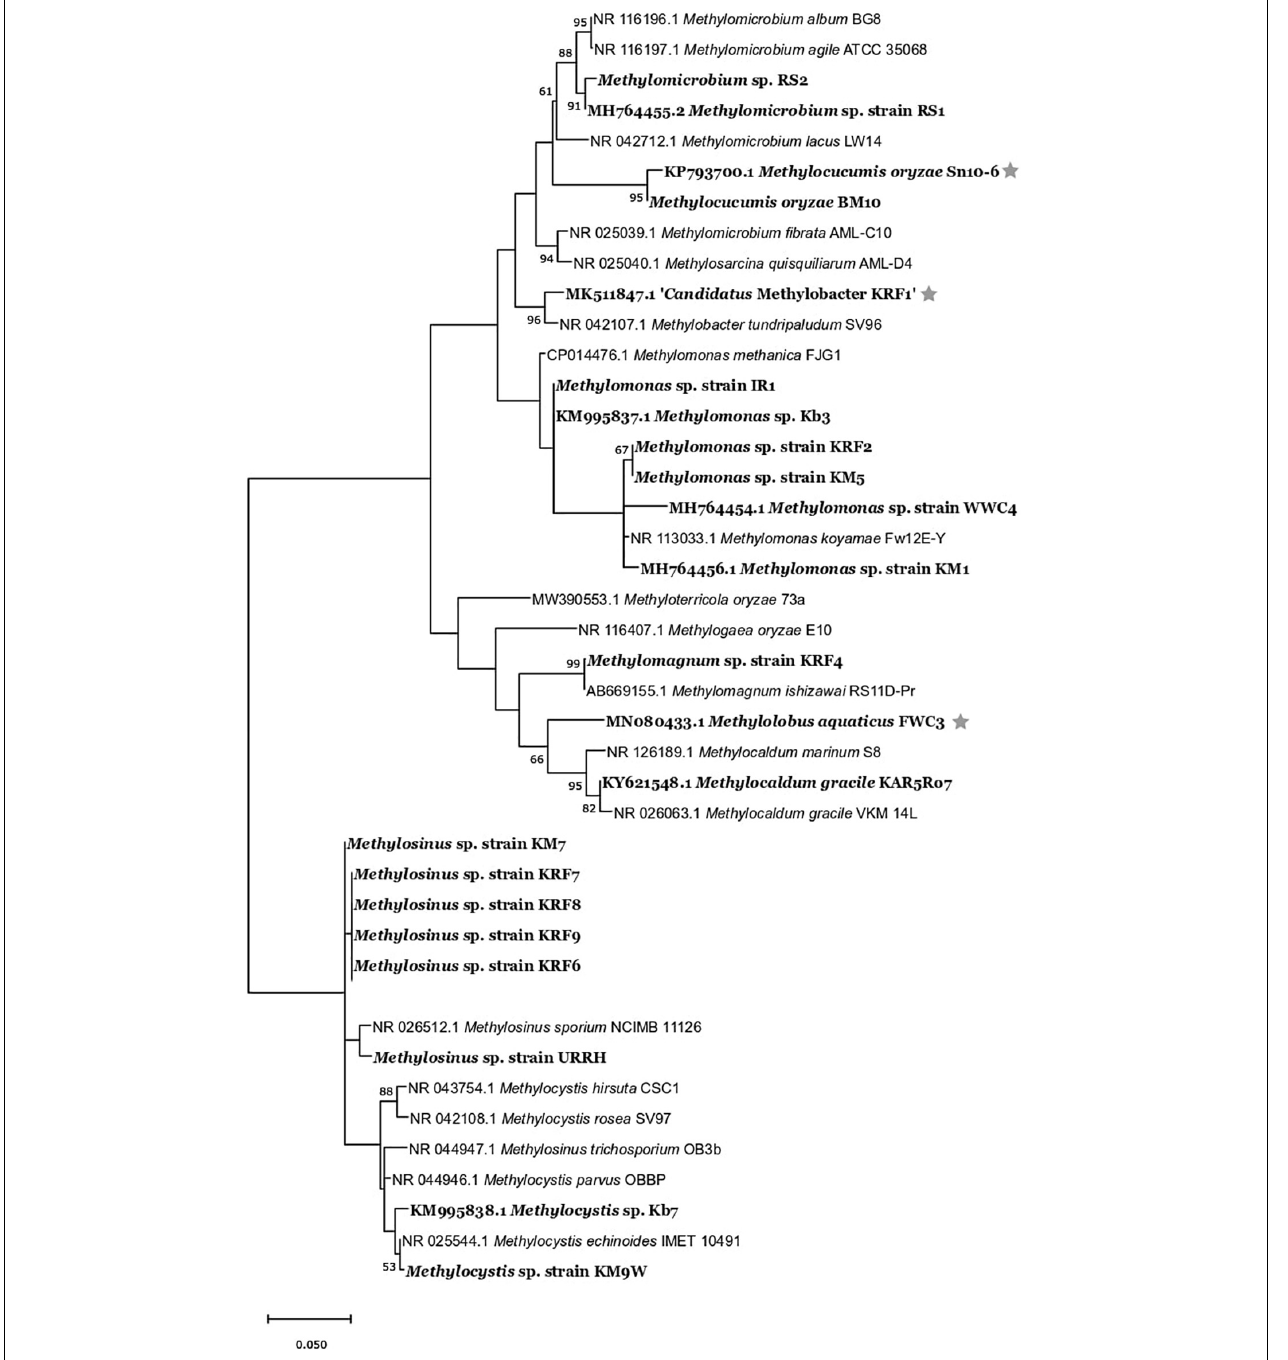
FIGURE 2 | Maximum-likelihood 1,000 bootstrap tree of 16S rRNA-based phylogenetic tree of all the strains (showed in bold) with their closest members. The evolutionary history was inferred by using the maximum-likelihood method and Tamura–Nei model (Tamura and Nei, 1993). Evolutionary analyses were conducted in MEGA X (Kumar et al., 2018). The bar represents 5% divergence. *Strains isolated in our previous studies.